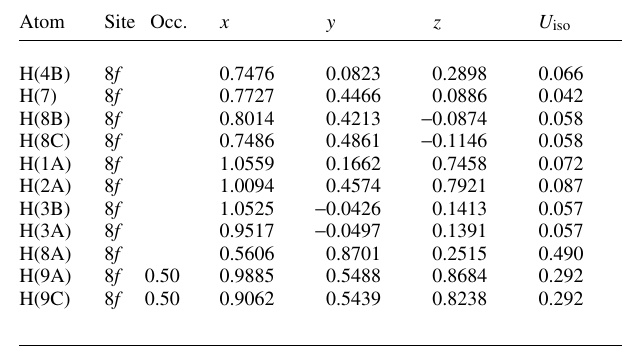
Table 2. Atomic coordinates and displacement parameters (in Å 2 ) . Atom Site